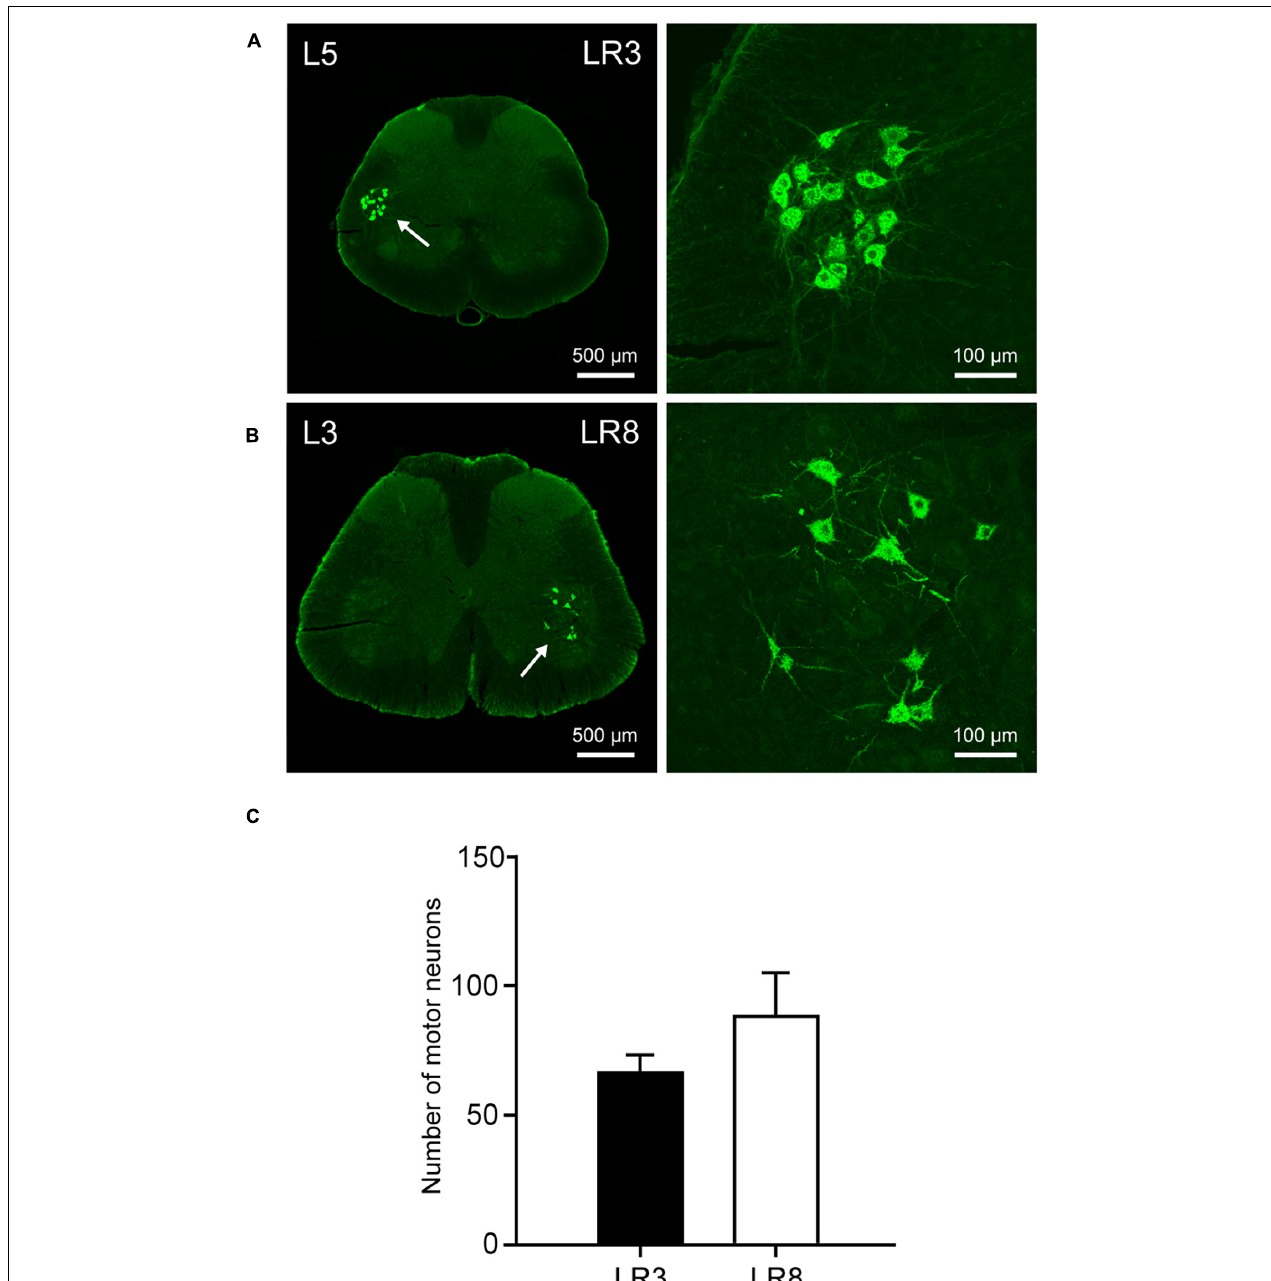
FIGURE 4 | Distribution of the labeled motor neurons with cholera toxin subunit B (CTB). (A,B) Representative photos from lumbar (L) 5 and L3 spinal segments showing the CTB labeled motor neurons associated with “Taichong” (LR3, A ) and “Ququan” (LR8, B ), their magnified photos (arrowheads) showing the motor neurons in detail. (C) The average number of CTB labeled motor neurons for LR3 and LR8 ( n =